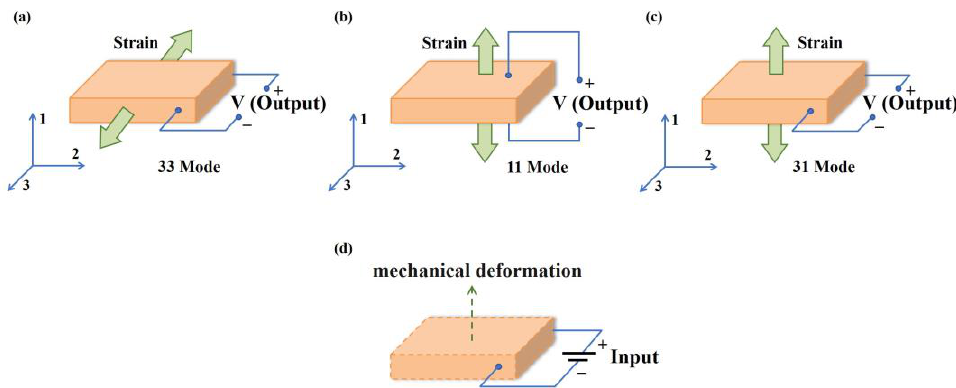
Figure 2. The schematic diagram of the piezoelectric energy conversion and collection devices (direct piezoelectric effect) and piezoelectric actuators (inverse piezoelectric effect). ( a ) 33 mode; ( b ) 11 mode; ( c ) 31 mode of direct piezoelectric effect. ( d ) Inverse piezoelectric effect.